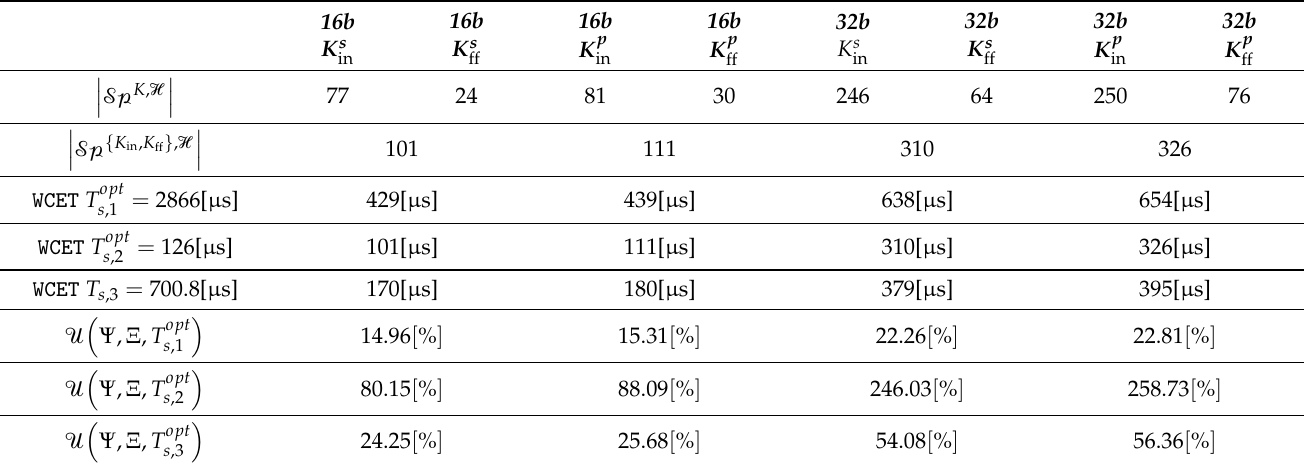
Table 10. DC motor case study WCET analysis in the conditions from Table 9, by emphasizing the number of assembly operations K in and K ff , along with the processor usage level for the three stable sampling rate